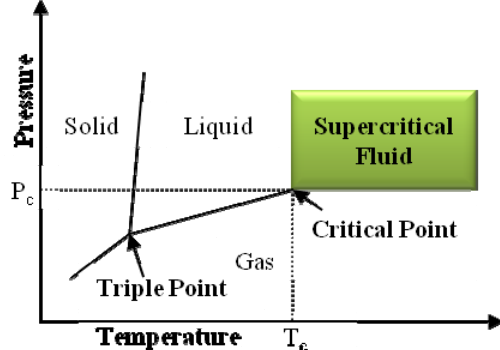
Figure 3. A simplified phase diagram for a pure phase substance illustrating density and T are the critical pressure and temperature, changes from liquid to gas. P c c